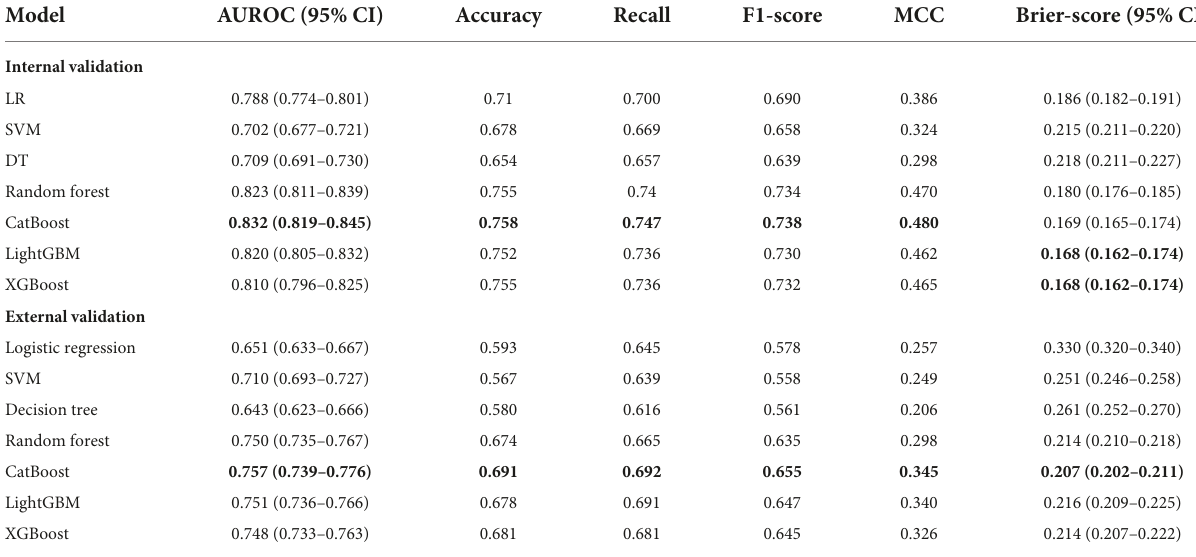
TABLE 2 Summary of models’ performance in internal and external